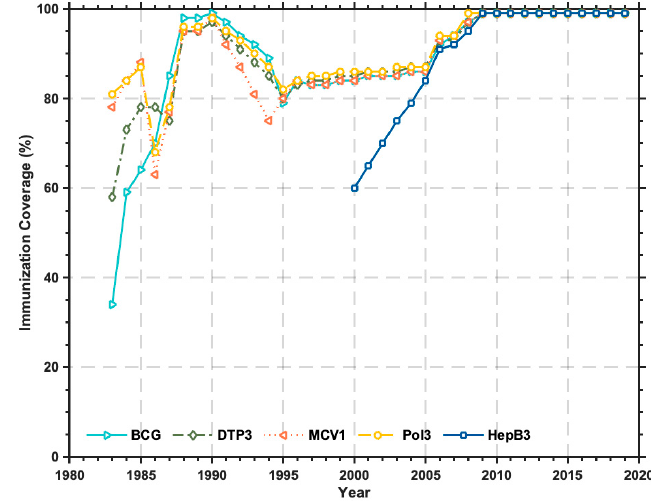
Figure 1. China’s immunization coverage since 1983.